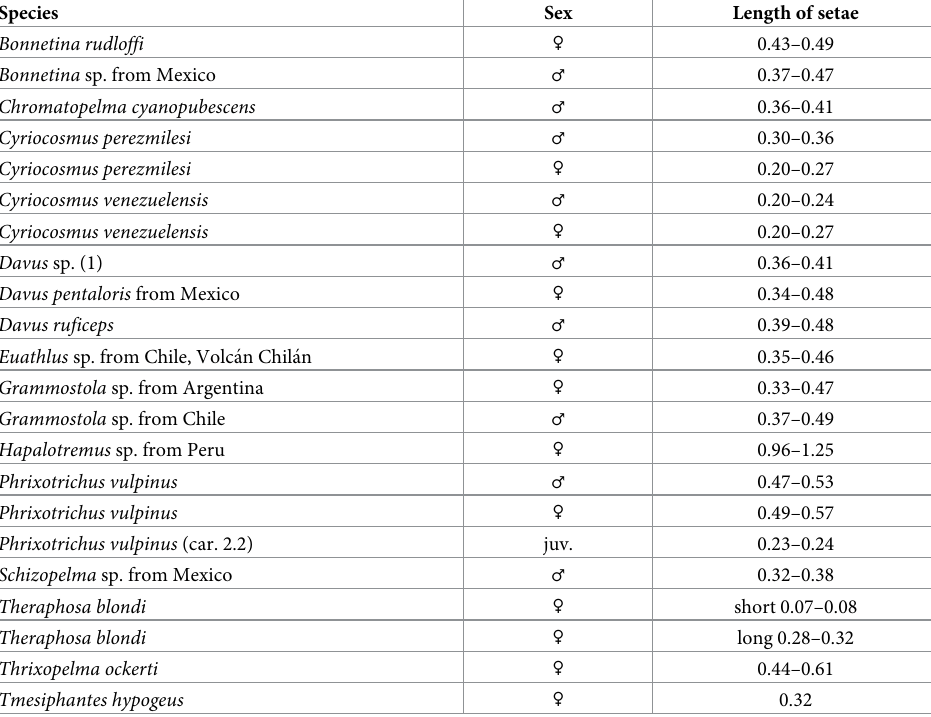
Table 10. Length ranges of type III setae. juv. = juvenile specimen. car. = length of carapace. Species